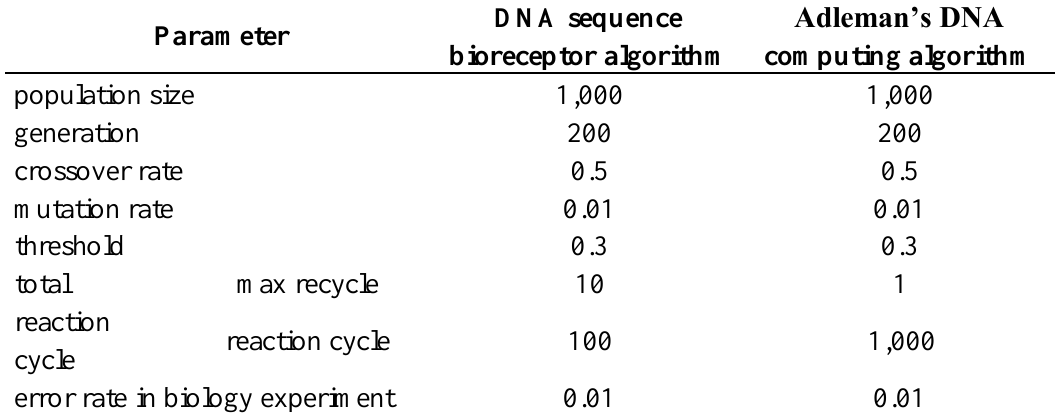
Table 3. Parameters.